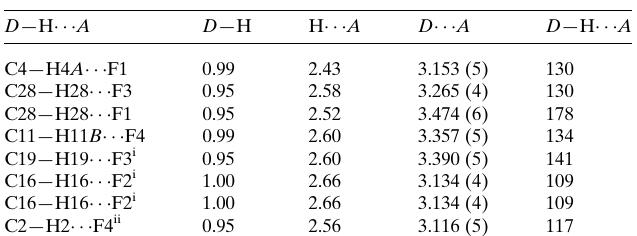
Table 1 Hydrogen-bond geometry (A˚ , (cid:5) ).